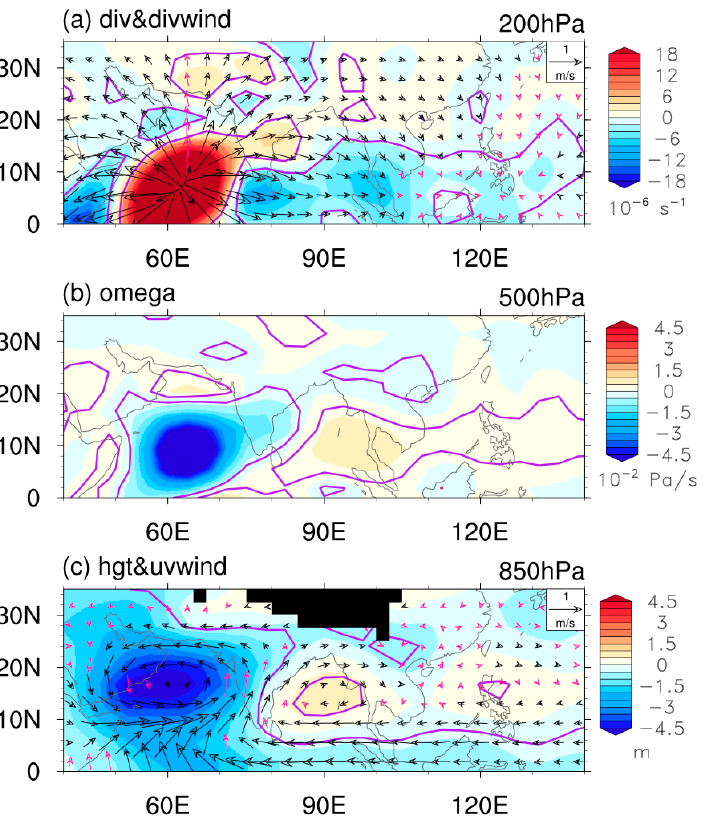
Figure 10. Similar to Figure 8, but for the difference between warm and cold northwest Indian Ocean simulations using SPEEDY.